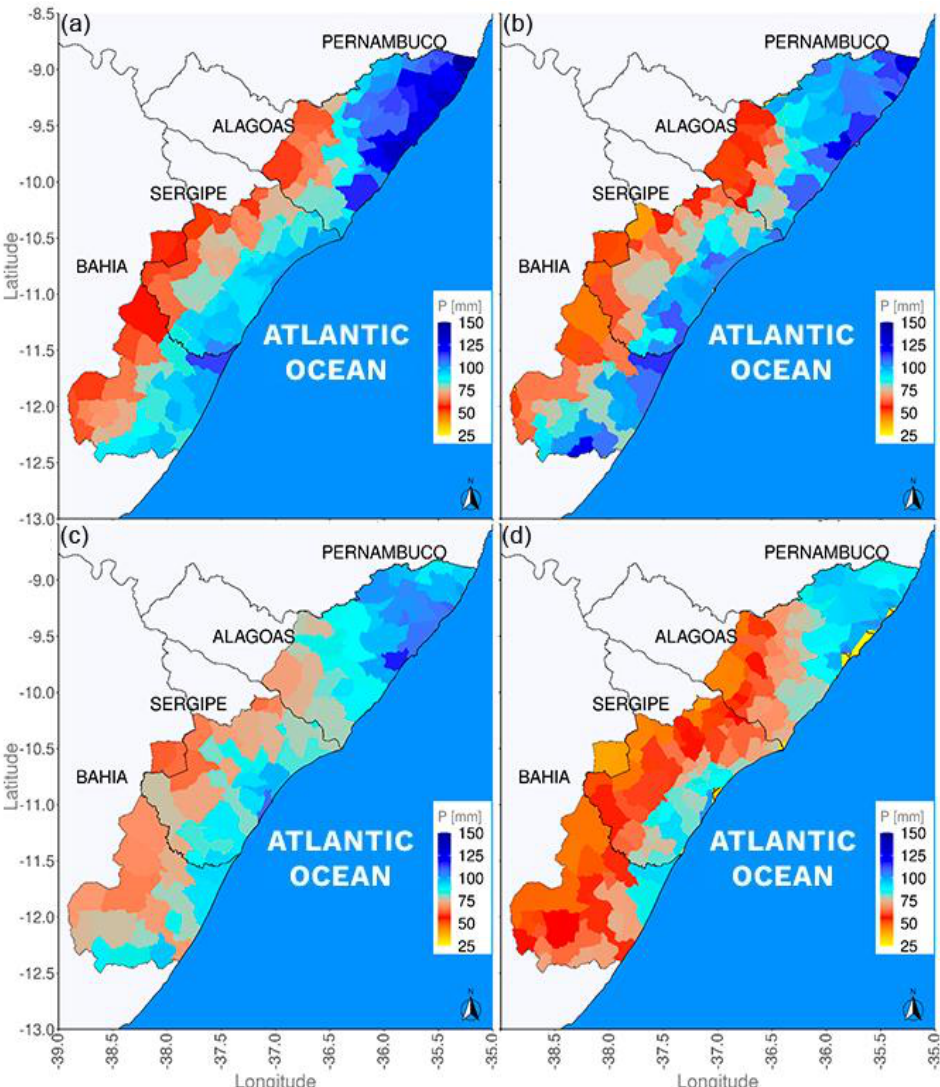
Figure 4. Annual monthly average of accumulated precipitation as per data from MERGE ( a ), CHIRPS ( b ), ERA5 ( c ), and ERA5Land ( d ). The precipitation scale on the map (P) varies from 0 to 150 mm.